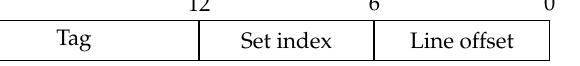
Figure 6. Cache indexing for 64-set cache and 64-byte cache